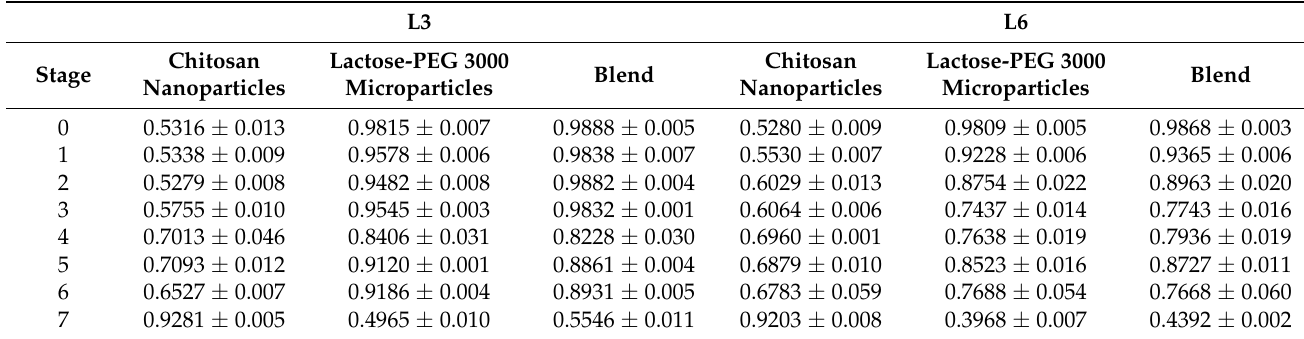
Table 5. FTIR spectra correlations of L3 and L6 admixed chitosan nanoparticles against chitosan nanoparticles, lactose-PEG 3000 microparticles and their